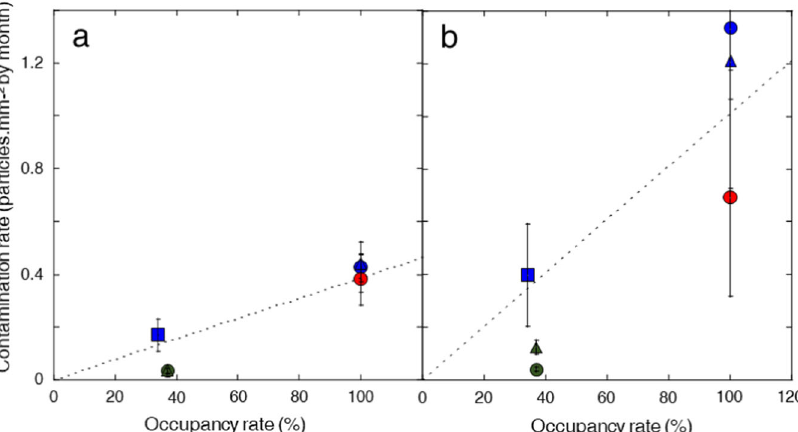
Fig. 4 Surface contamination rate ( θ ) versus Occupancy rate ( η ). a Surface contamination rate values of the coarse particles (50 μ m 2 < Area < 1500 μ m 2 ). b Surface contamination rate values of the fi ne particles (0.50 μ m 2 < Area < 50 μ m 2 ). Red and green dots show the FDTS-surfaces exposed for 193 days in MATISS-1 and 365 days in MATISS-2.5, respectively, blue dots for the different experimental periods of MATISS-2 (41 days, 95 days and 354 days). Each holder has its symbol. Error bars represent the standard deviation of the data. The dashed curves are guide-eyes of an increase of the surface contamination rate with the occupancy